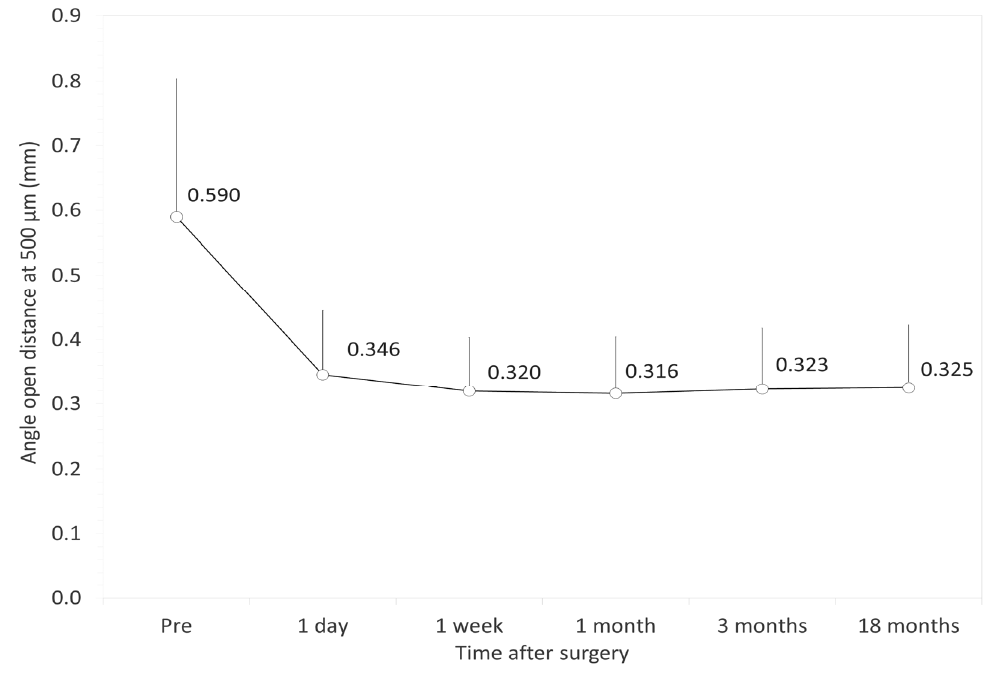
Figure 2. Time course of the angle opening distance at 500 µm (AOD500) after implantable collamer lens (ICL) implantation. The AOD500 was significantly decreased 1 day postoperatively and subsequently stabilized over time. Bar represents standard deviation.